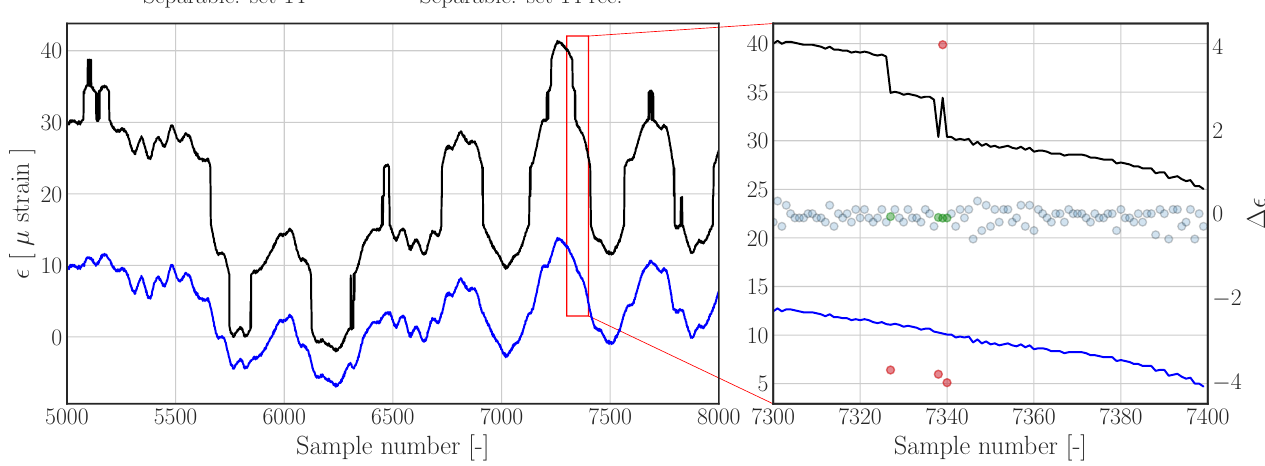
Figure 9. Left : Subset of data set 14 from Separable.hdf5 (dashed), and reconstructions (solid) using the threshold filter based method . Right : Zoom in on region containing jumps. Nominal difference samples are indicated with blue dots, outliers and corresponding outlier replacements are indicated by red and green dots,